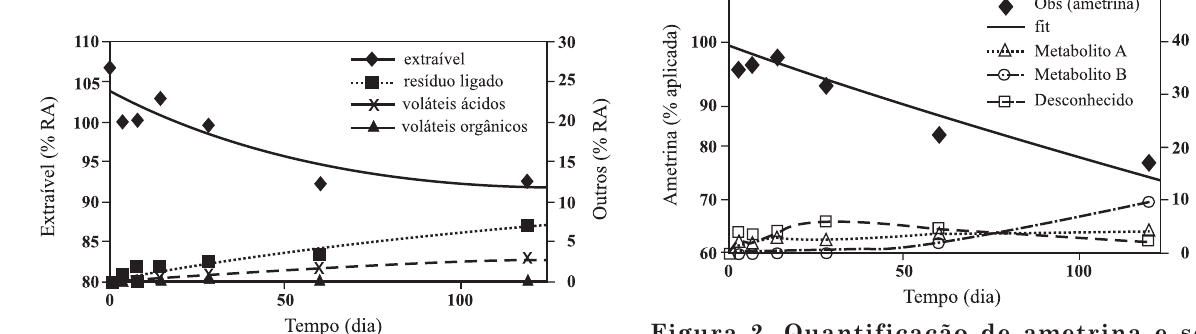
Figura 1. distribuição da radioatividade aplicada durante o período de incubação (solo lvdf).